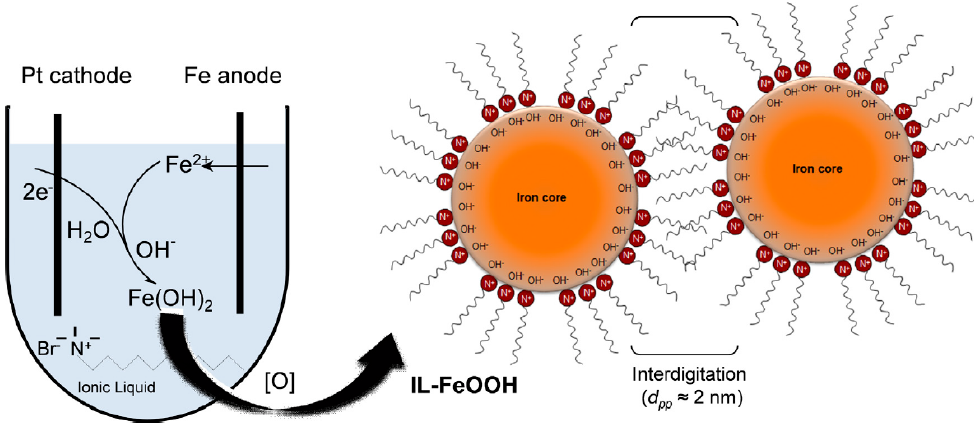
Figure 10. Schematic representation for the production of FeO 2 H particles coated with an ionic liquid-based surfactant layer [194]. Reprinted with permission from ref. [194]. Copright 2021 Elsevier.